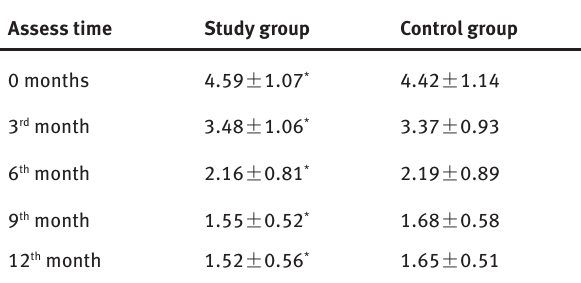
Table 4: The analysis of ACQ scores between two groups.